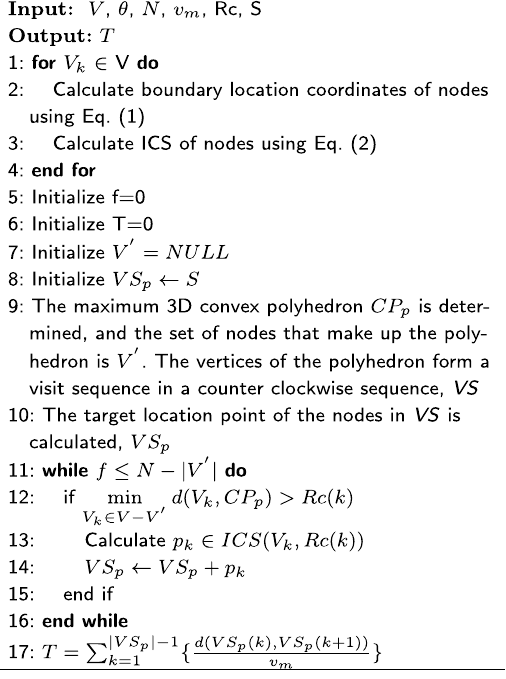
Algorithm 1 Data Collection Algorithm ICS-DDCA-